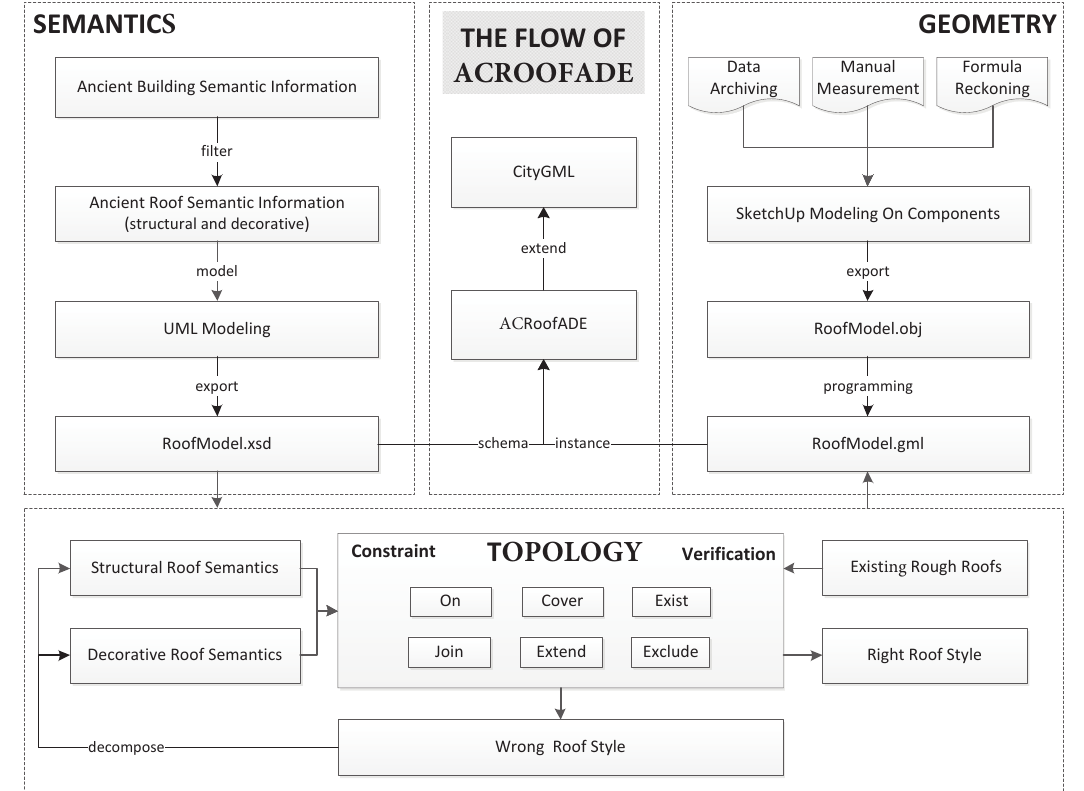
Figure 8. The flowchart of generating ACRoofADE (semantics, geometry and